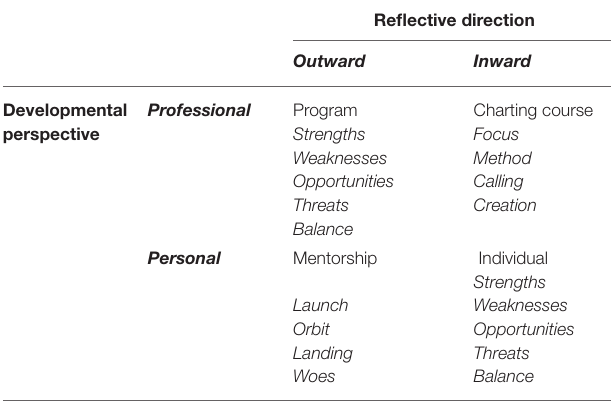
TABLE 1 | Developmental perspectives, reflective directions, four domains, and underlying themes for